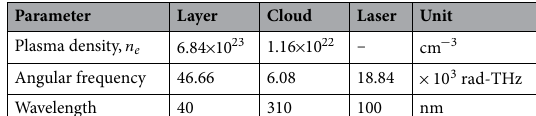
Table 1. Layer and cloud plasma versus laser parameters.